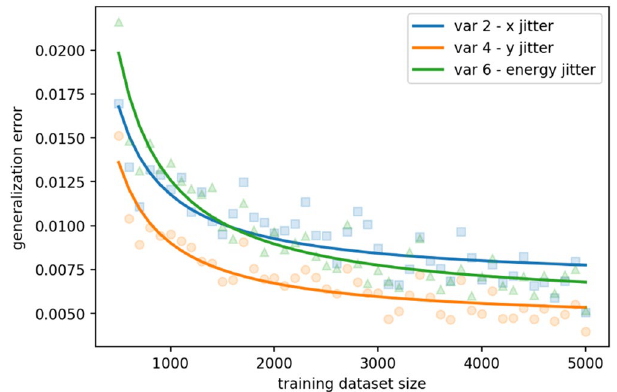
Figure 6. The results for one round of training with image numbers ranging from 500 to 5000 with a step size of 100. The generalization error in the plot is the RMS error of the trained model prediction based on all the available data of 5000 images. The scatter points are the raw data and the solid lines are the inverse fittings to the raw data 41 . The training for each dataset size has been rerun for 10 times to get less noisy data.